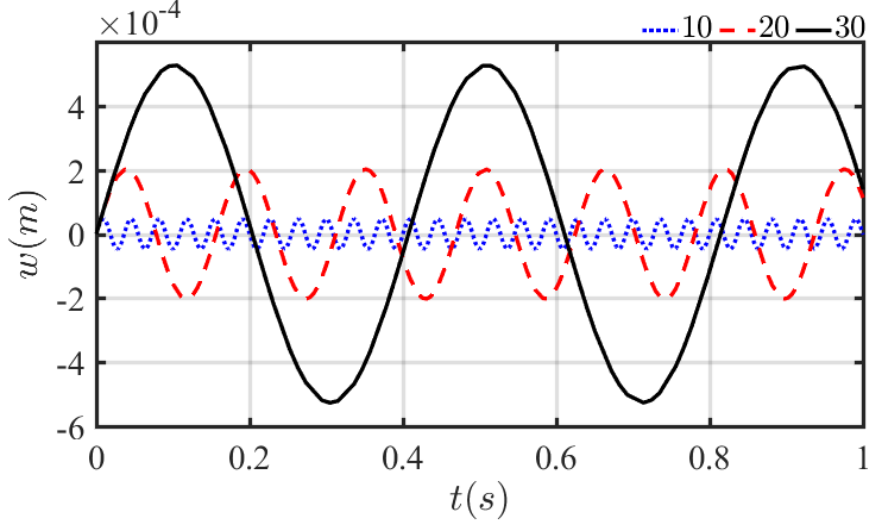
Figure 13. Effects of pipes conveying fluid length-to-thickness ratio on nonlinear transient vibra ‐ tions.